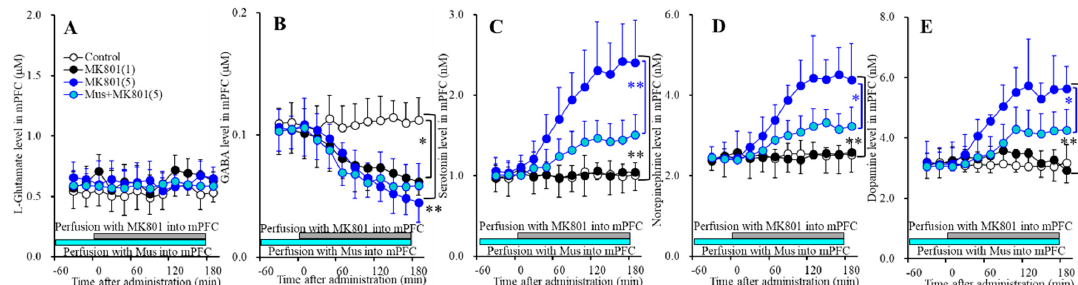
Figure 1. Concentration-dependent effects of local administration of MK801 (0, 1 and 5 μ M) into the mPFC on extracellular levels of L -glutamate ( A ), GABA ( B ), serotonin ( C ), norepinephrine ( D ), and dopamine ( E ) in the mPFC (Study_1). Ordinates: mean ± SD ( n = 6) of extracellular transmitter levels ( μ M or nM); abscissa: time after MK801 administration (min). Light blue and gray bars indicate perfusion with muscimol (Mus) and MK801 into the mPFC, respectively. * p < 0.05, ** p < 0.01; relative to control or 5 μ M MK801 by multivariate analysis of variance (MANOVA) with Tukey’s post hoc test.